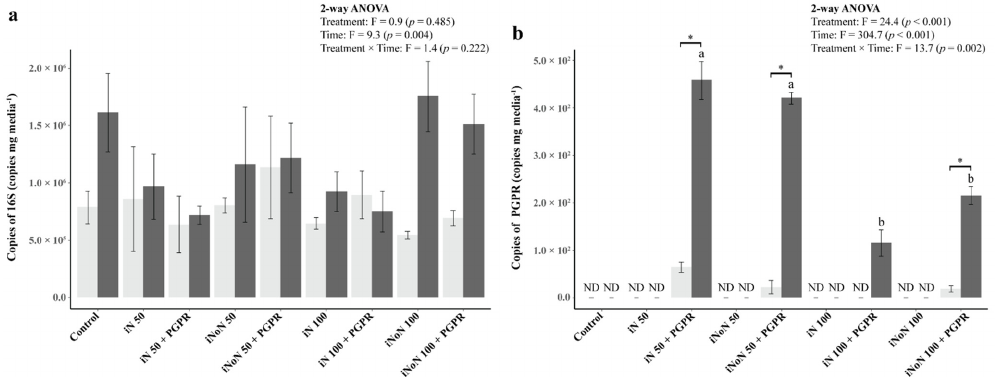
Figure 4. Copy numbers of the ( a ) 16S rRNA gene and ( b ) PGPR strain-specific gene PB_SOS3_004375 from rhizosphere potting mix of macadamia seedlings after 12 weeks (light grey bars) and 28 weeks (dark grey bars) growing under different fertilizer-N sources (iN, iNoN) without or with PGPR inoculation. Shown are the total number of gene copies per mg of soil ( ± SE, n = 3). Asterisks and parentheses in panel ( b ) indicate significant differences between time points within treatments (one-way ANOVA, p < 0.05), while different lowercase letters above means indicate significant differences among treatments within a time point (one-way ANOVA and Tukey’s post hoc test, p < 0.05). ND : number of copies below limit of detection.